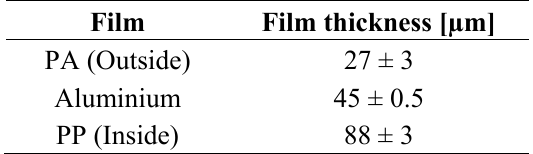
Table 1. Thicknesses of individual pouch package layers.